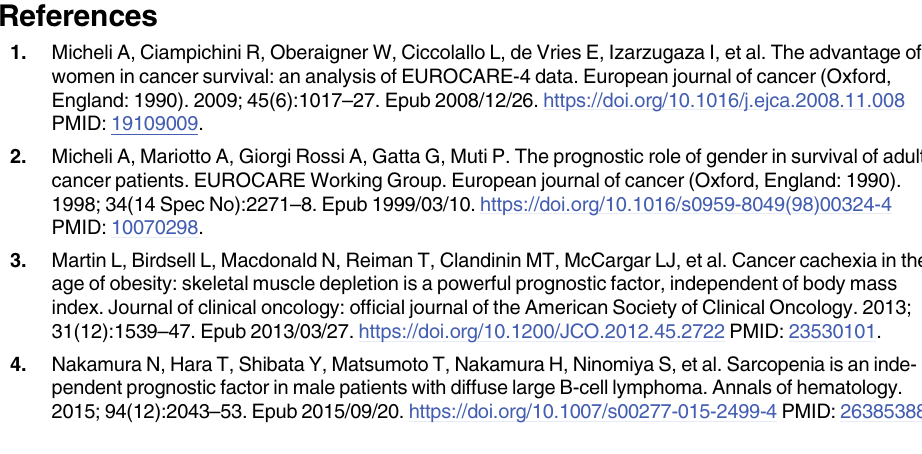
S1 Table. Characteristics of gastric cancer